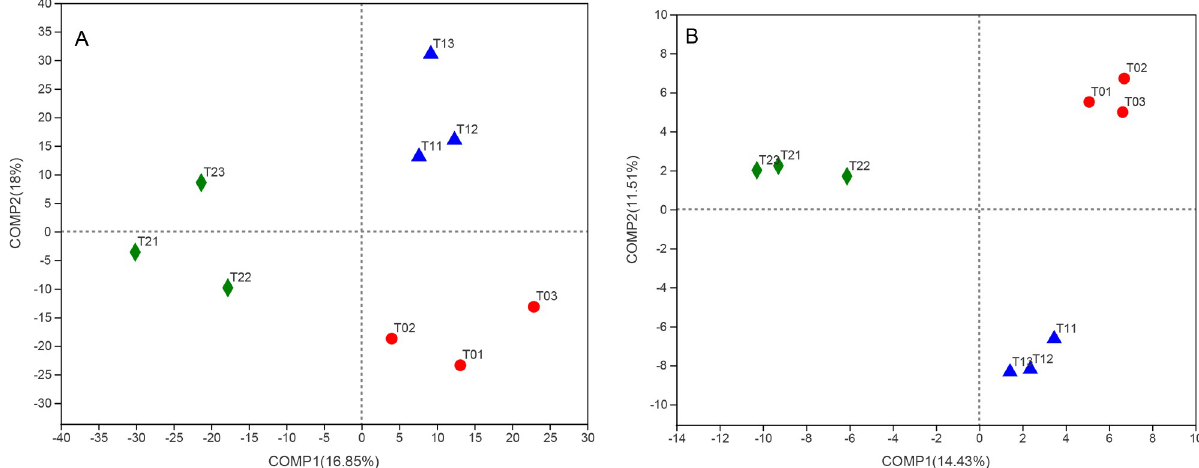
Fig 5. Partial least squares discriminant analysis (PLS—DA) is an adaptation of PLS regression methods to represent differences in the community structure of bacterial (A) and fungal (B) microbiota that was associated with T0, T1, and T2. Notes: T0 = Traditional irrigation; T1 = Traditional irrigation and fertilization practice; T2 = Water-saving irrigation and optimizing